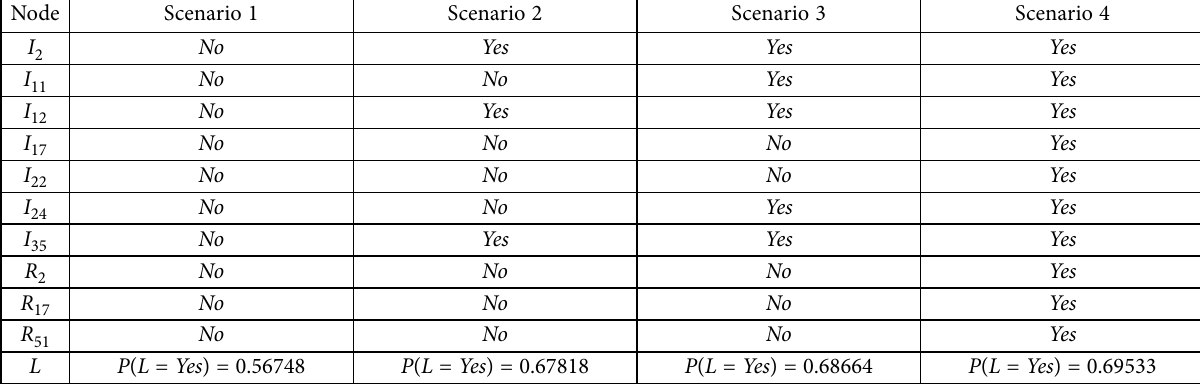
Table 4. The results of four hypothetical scenarios of the FBBN-based RA model for the Ankara-Istanbul high-speed railway project